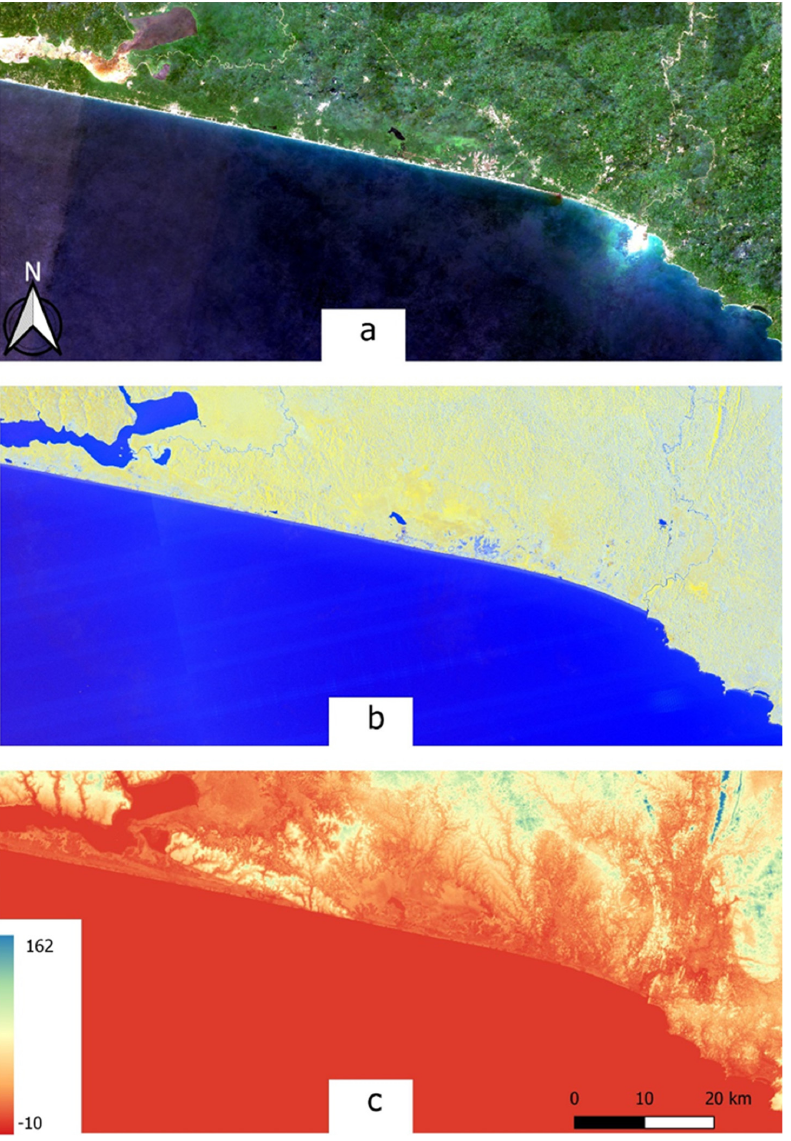
Figure 2. Satellite image data of the study area: ( a ) Sentinel-2 true colour composite, ( b ) Sentinel-1 dual-polarization and ( c ) SRTM DEM showing estimated elevation in metres above sea level.